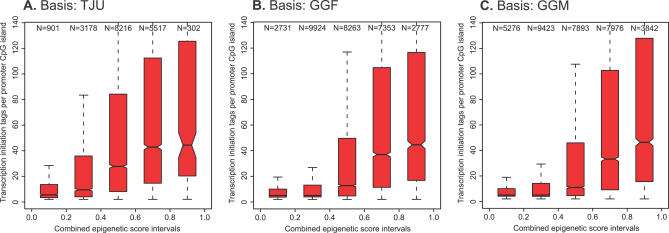
Box Plots Comparing the Promoter Strength between High-Scoring and Low-Scoring Promoter CpG IslandsThis figure shows box plots of the average number of transcription start site tags per CpG island (as an indicator of promoter strength), restricted to those CpG islands that show experimental evidence of promoter activity at all (i.e., at least three transcription start site tags fall within the CpG island). Separate box plots are drawn for CpG islands that fall into different intervals in terms of their combined epigenetic score (i.e., 0 to 0.2, 0.2 to 0.4, etc.). The standard box plot format is used (boxes show center quartiles, whiskers extend to the most extreme data point that is no more than 1.5 times the interquartile range from the box, and non-overlapping notches provide evidence of significantly different medians), and outliers are hidden.